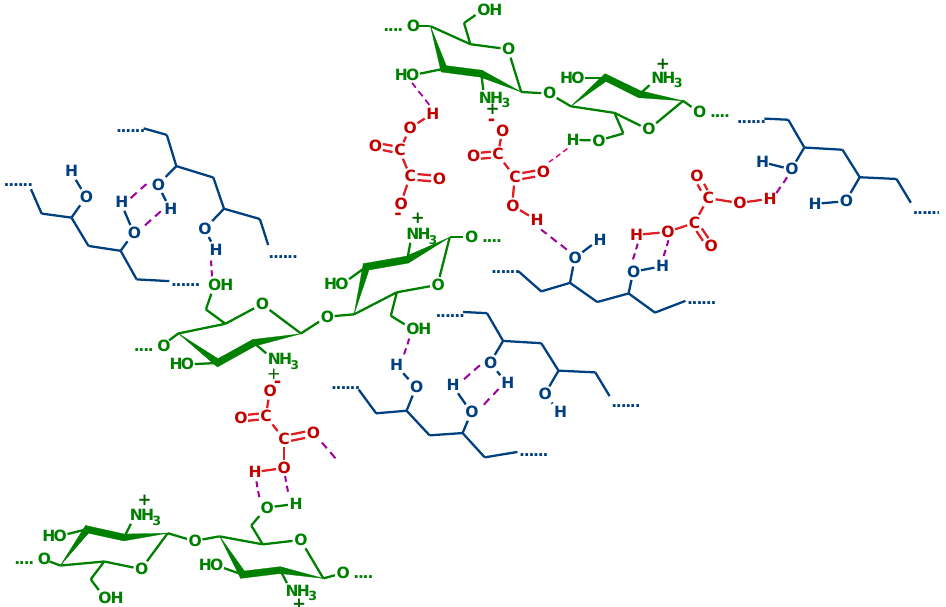
Figure 3. Schematic representation of possible physical interactions in the PVA/CS/OA hydrogels. The morphology of PVA/CS/OA hydrogels with different weight ratios between PVA and CS was examined by scanning electron microscopy (SEM) (cross-section of the hydro- gels previously washed and dried by lyophilization). The obtained images and the distri- bution of the pores diameters are presented in Figure 4. The porous structure and the interconnected pores, characteristic for F-T technique, offer a high permeability for gases and water vapor required for wound-dressing applications. The hydrogel with PVA:CS ratio of 75:25 has a regular pore distribution with a mean pore diameter of 59 μm. With the increase of the CS content, the pore distribution became wider because CS reduced the entanglement of the PVA chains [60] and the formation of the PVA crystallites [32]. The increase of the porosity of freeze – thawed PVA/CS hydrogels with the increase of the CS content was also observed in the literature [31,32,34]. The hydrogel obtained only from CS and OA has a sponge-like structure with higher pores diameter ( 137 μ m) and thicker walls compared to PVA/CS/OA hydrogels.